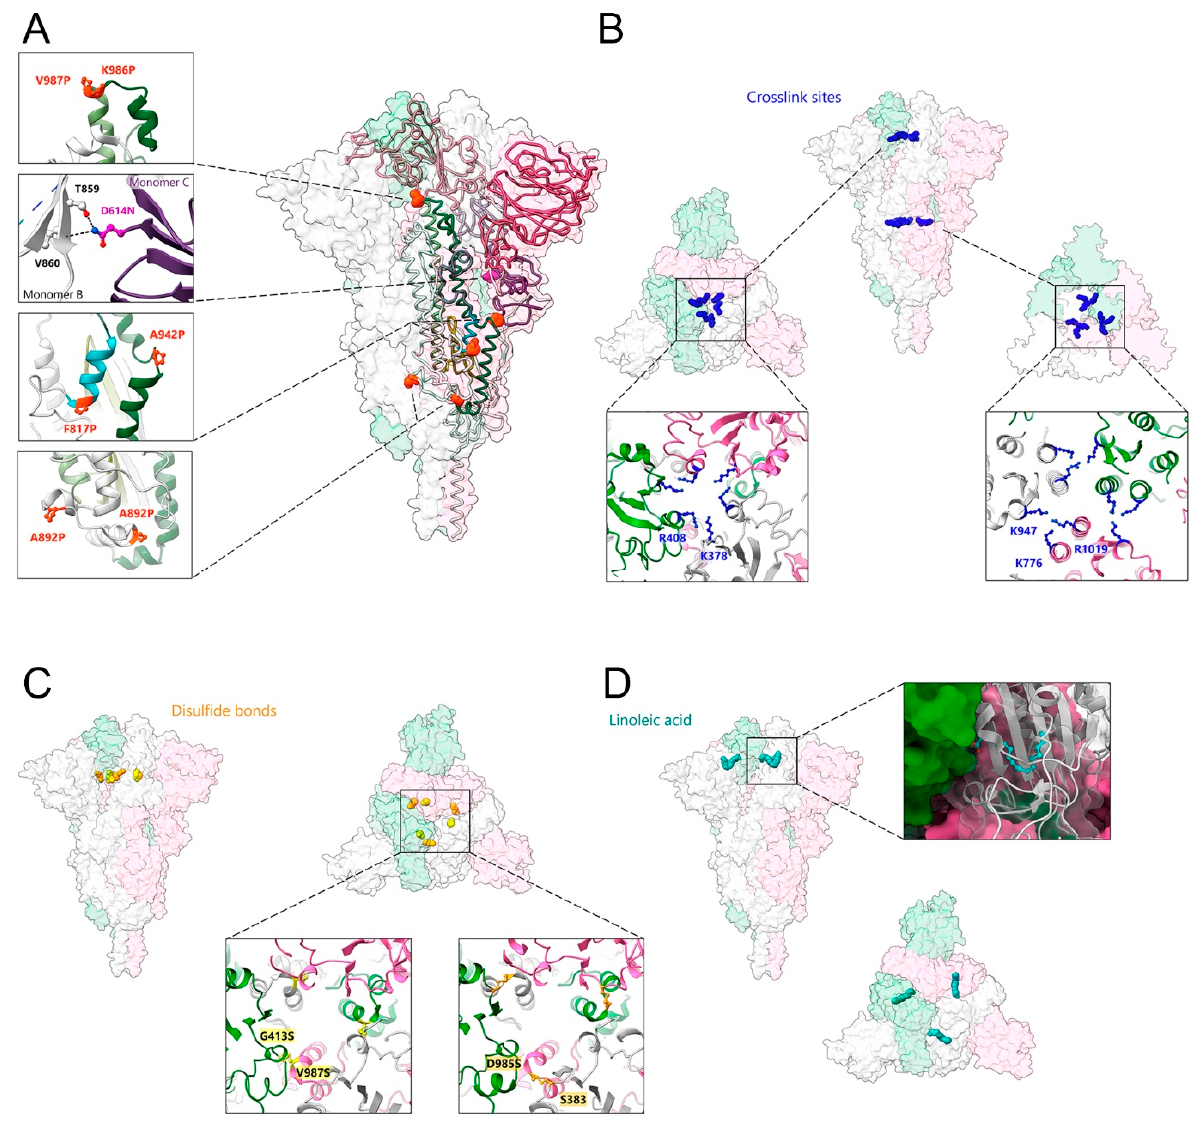
Figure 2. Strategies of SARS-CoV-2 spike protein stabilization. ( A ) Introduction of stabilizing mutations. Close-ups of the orange spheres represent proline substitutions K986P, V987P, F817P, A892P, A899P, and A942P (PDB:6XKL) [105]. Close-up of the violet spheres corresponding to the mutation of D614 to asparagine, which directly contacts T859 and V860 from the adjacent protomer; residue mutations at positions R82S and R685G are disordered (PDB:7A4N) [106]. ( B ) Chemical crosslinking by formaldehyde mediates the formation of covalent bonds between adjacent protomers by residues K378 and R408 (close-up to the left ) and by residues K947 and K776 and/or R1019 (close-up to the right ) (PDB: 7Q1Z) [107]. ( C ) The introduction of disulfide bonds between adjacent protomers at positions G413C and V987C (close-up to the left ; PDB: 6ZOX) and at S383C and D985C (close-up to the right ) (PDB: 6ZOY) [108]. ( D ) The binding of linoleic acid (in cyan blue) into an RBD pocket stabilizes the spike protein in the prefusion conformation (close-up to the right shows one of the RBDs in the ribbon accommodating linoleic acid) (PDB: 6ZB5)